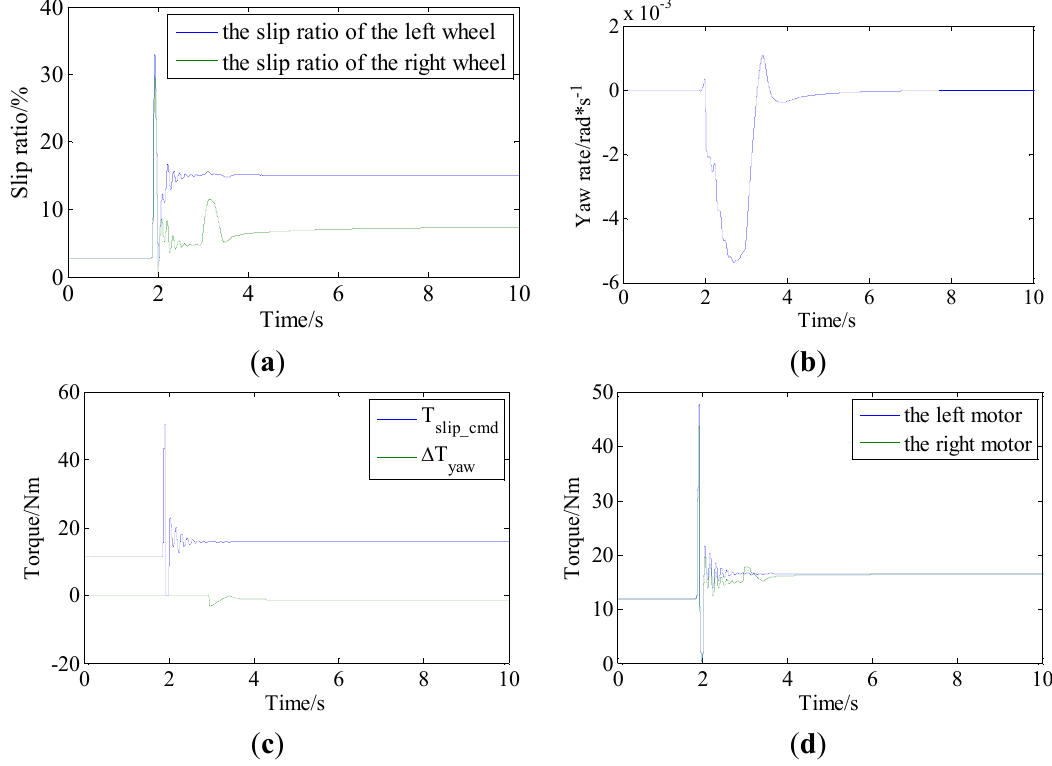
Figure 8. Simulation results of acceleration slip regulation on low friction road: ( a ) slip ratios of driving wheels; ( b ) yaw rate of vehicle; ( c ) torque commands of slip ratio control and yaw rate control; and ( d ) motor torque